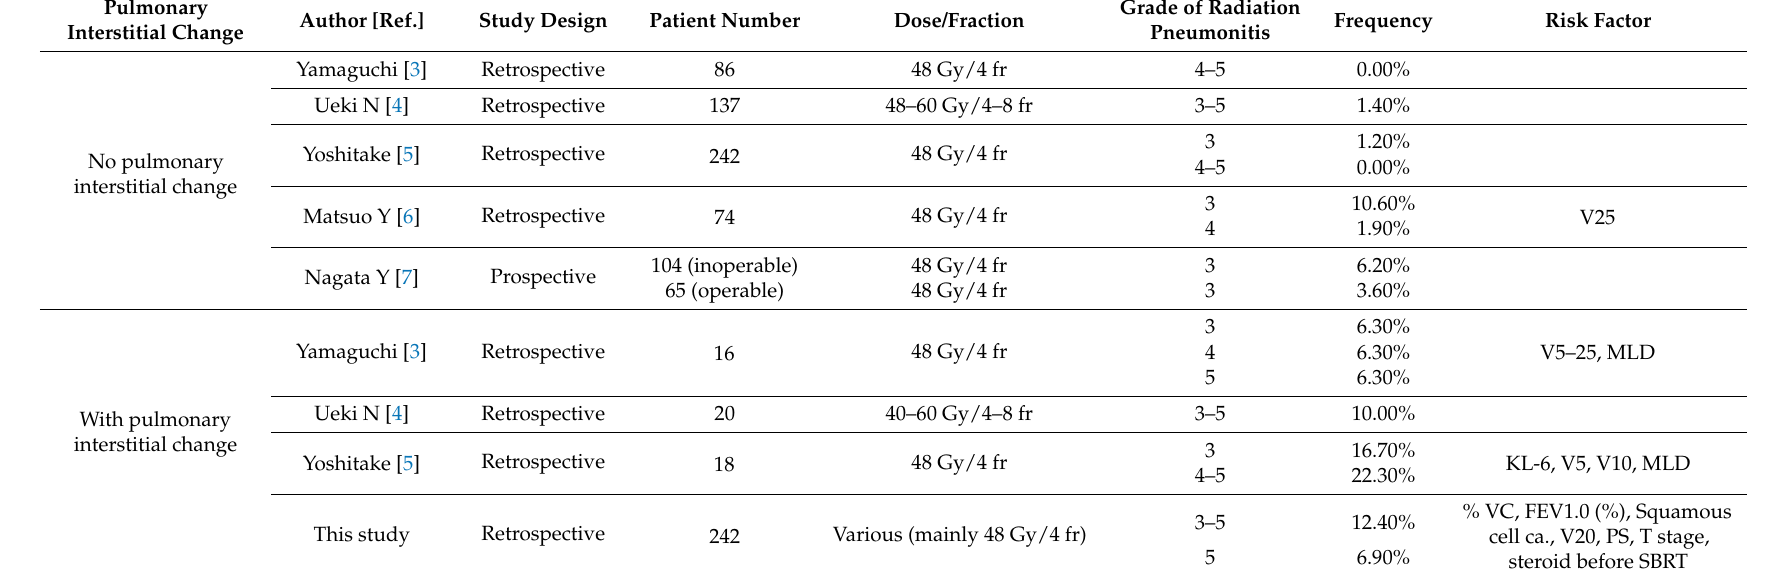
Table 4. Frequency of radiation pneumonitis post SBRT for lung cancer according to presence of pulmonary interstitial